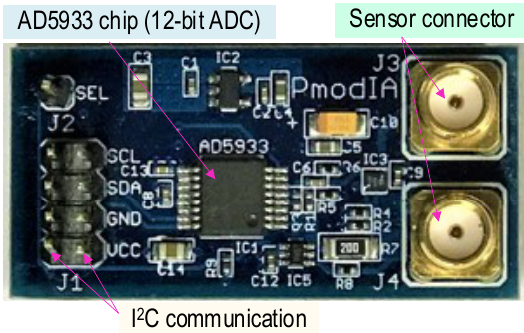
Figure 2. Impedance sensing module ‘PmodIA’.